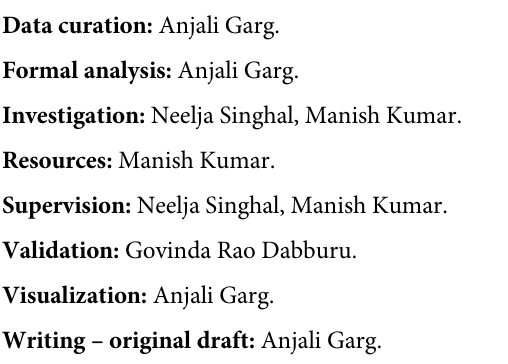
S2 Table. Bacterial and Viral-set host and pathogen mimicry proteins containing IDPRs, SLiMs, MoRFs, and LCR. Proteins in which mimicry epitope overlapped with the IDPRs, SLiMs, MoRFs, and LCR are also shown (PDR: Percentage of disordered residues). S3 Table. The sequence and position (shown in parenthesis) of MoRFs/SLiMs/LCRs into the host and pathogen mimicry proteins. S4 Table. Functional annotation of Bacterial and Viral-set mimicry proteins on the basis of gene ontology (GO) term. The GO-term is mentioned for all three categories namely (i) Biological Process (ii) Molecular Function (iii) Cellular